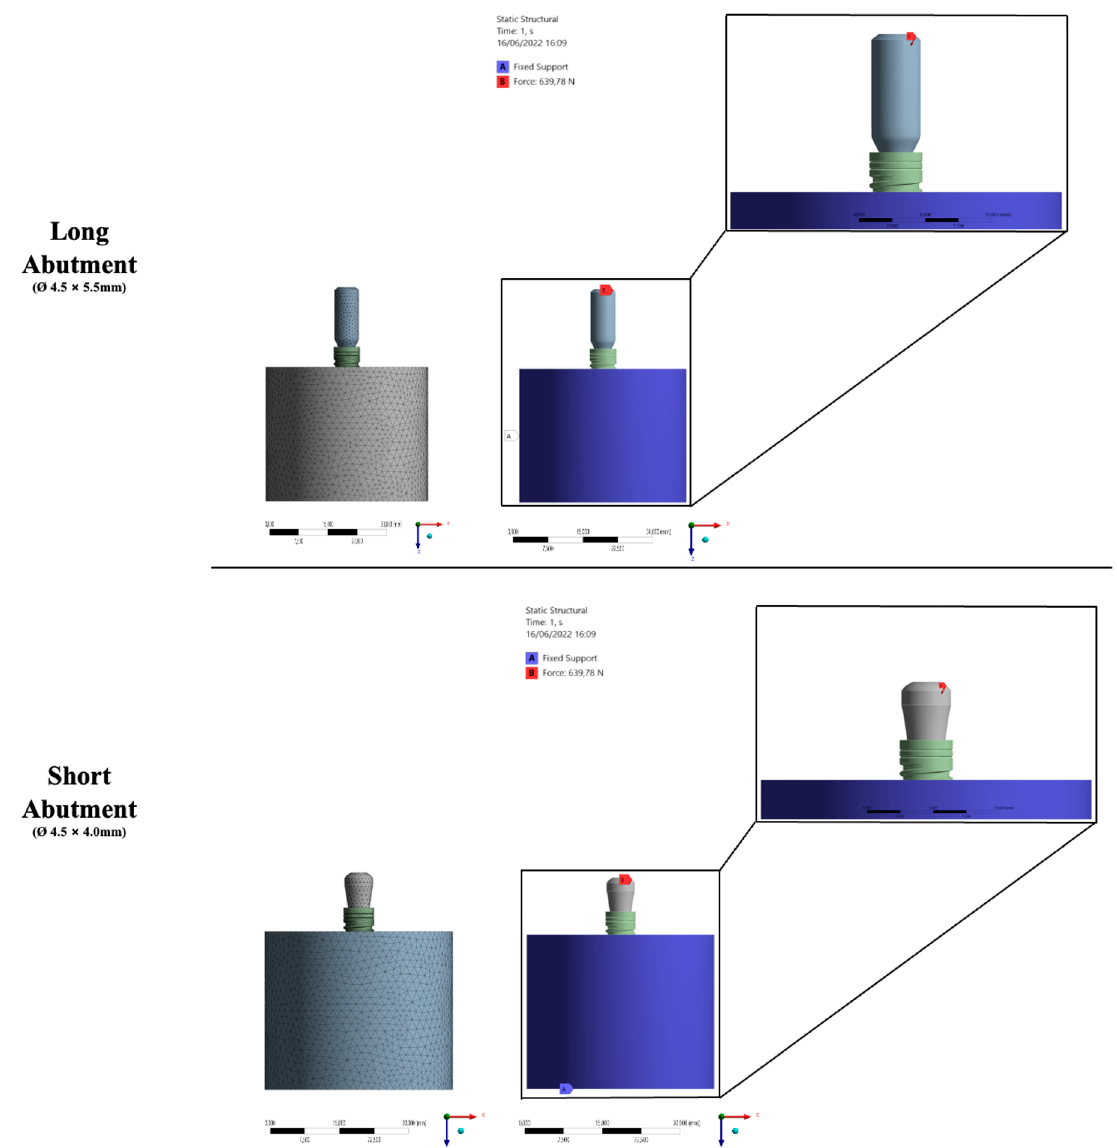
Figure 2. FEA details—Mesh, boundary conditions, loads, and connections.